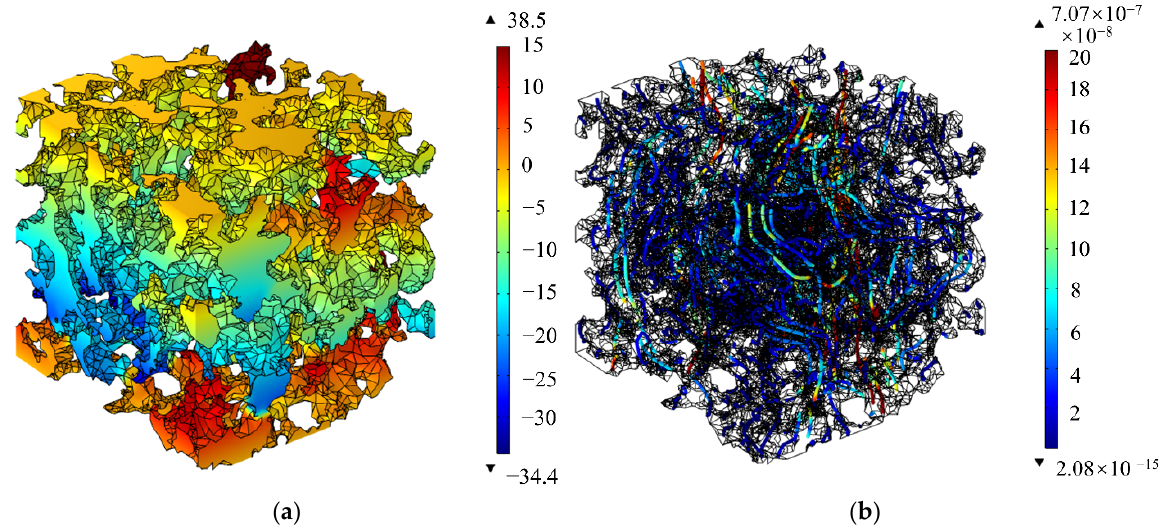
Figure 17. Pressure and velocity streamlines: ( a ) Pressure distribution; ( b ) Velocity streamlines distribution.